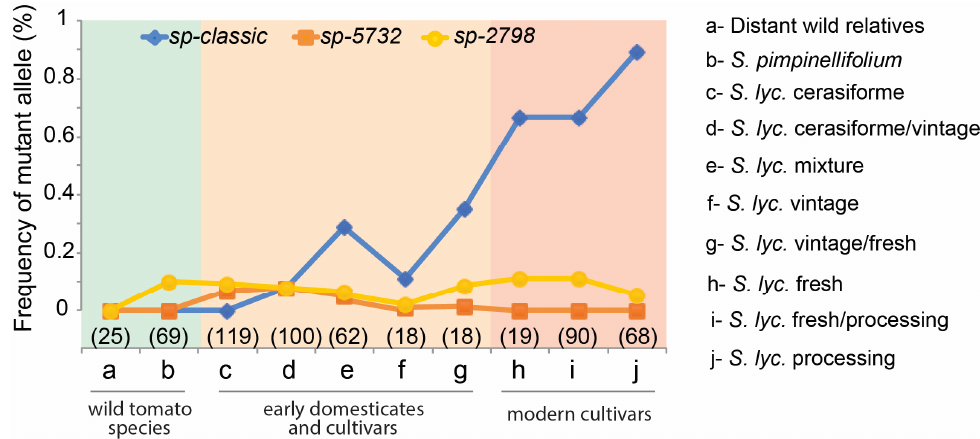
Figure 3. Allele frequencies of sp alleles in accessions classified as wild Solanum species (distant relatives and S. pimpinellifolium , the wild progenitor of domesticated tomato), early domesticates and cultivars ( S. lycopersicum var. cerasiforme and S. lycopersicum vintage), and modern cultivars (fresh-market and processing). Number of accessions is indicated in